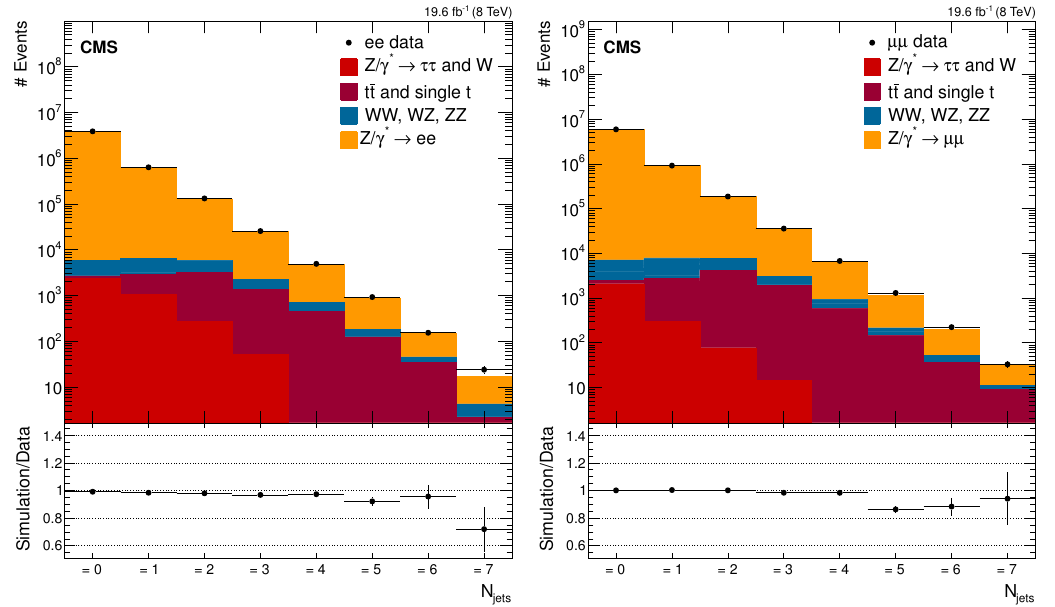
Figure 1 . Exclusive jet multiplicity for (left) the electron and (right) the muon channels at detector level in the jet rapidity region j y j < 2 : 4. The data points are shown with statistical error bars. Beneath each plot the ratio of the number of events predicted by the simulation to the measured values is displayed, together with the statistical uncertainties in simulation and data added in